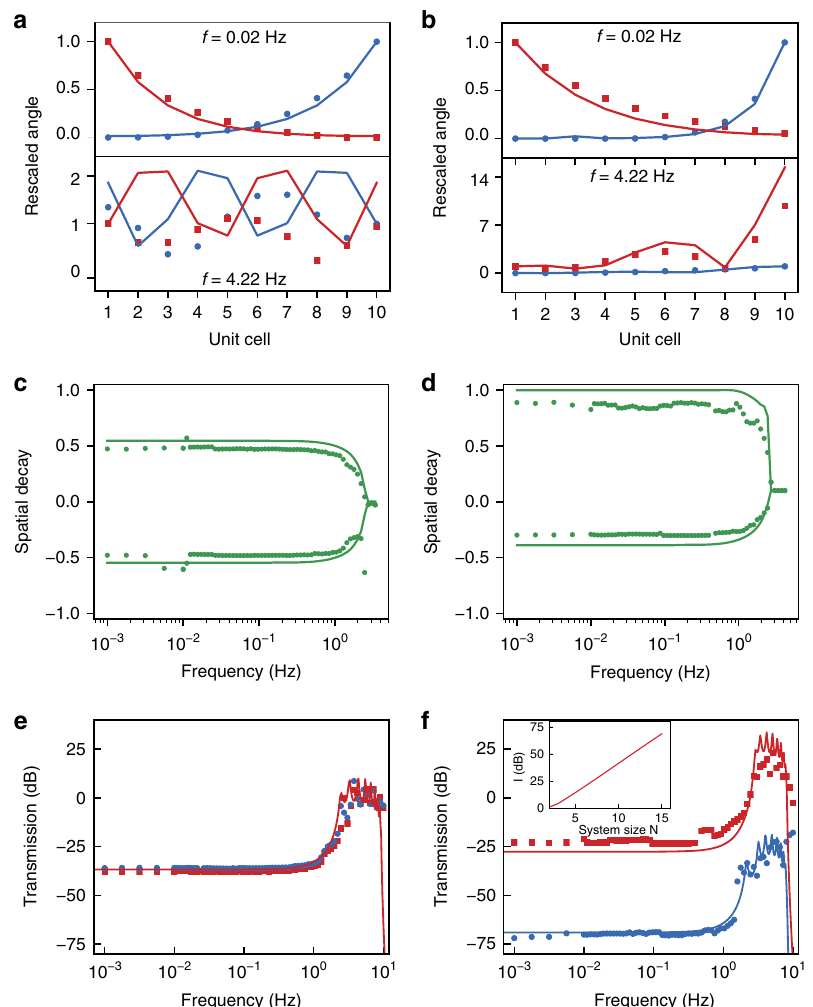
Fig. 3 Spatially asymmetric standing waves and broadband unidirectional transmission. Stationary response under sinusoidal excitations at the left (red squares) or right (blue dots) edge of the metamaterial. (ab) Amplitudes of oscillation rescaled by the amplitude of actuation as a function of the unit cell position for sinusoidal excitations with α = 0 ( a ) and α = 0.43 ( b ) at frequencies 0.02 Hz (top) and 4.22 Hz (bottom). See also Supplementary Video 1. (cd) Spatial decay rates of the amplitudes of oscillation vs. frequency with α = 0 ( c ) and α = 0.43 ( d ). (ef) Left-to-right ( T L → R ) and right-to-left ( T R → L ) transmissions as a function of the excitation frequency (f) for a feedback parameter α = 0 ( e ) and α = 0.43 ( f ). (f-inset) Isolation at low frequency I = T − T α = 0.43. For each graph, markers depict the experiments and solid lines the numerical model. L → R R → L as a function of the number of unit cells N, for Note that beyond 10 Hz our experimental system cannot drive and